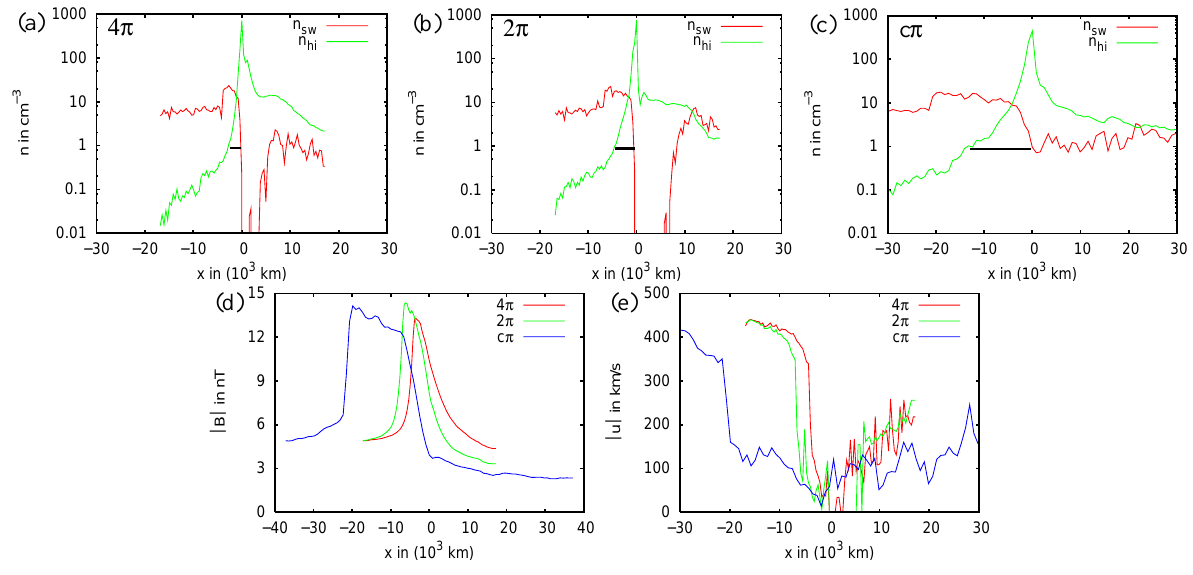
Fig. 5. 1-D plots along the x-axis at 1.30AU. Panels (a) , (b) , (c) show the solar wind and the cometary ion density for the three models. Panels (d) , (e) compare the magnetic field and the solar wind bulk velocity for the investigated mass-loading patterns. Due to the high degree of mixing between the species in the c π case (c) the ICB is only gradually developed. The increase of the mixing region between the two species leads to a broadening of the MBR shown in (d) and a smooth deceleration of the solar wind shown in (e).